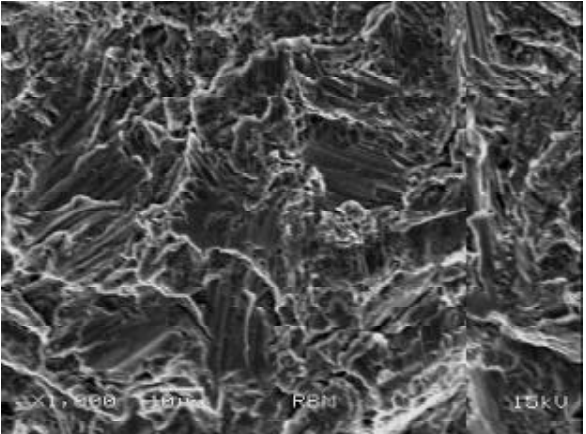
FIGURA 4- Limite entre a porção rugosa e lisa. Observar a dissipação de resíduos (seta) (x200)